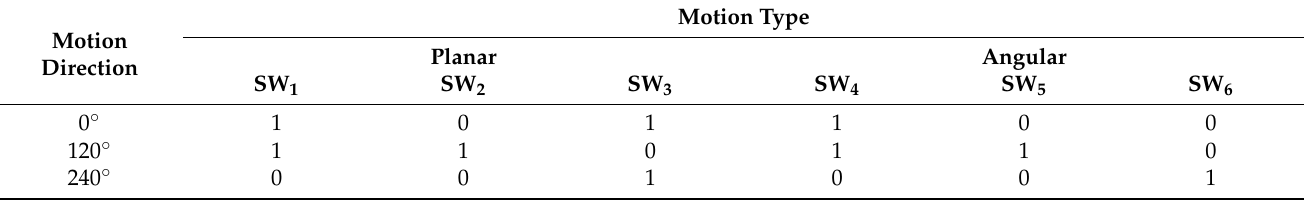
Figure 3. Excitation schematics of the robot; 1—excitation signal source; 2—switching box dedicated to controlling planar motion; 3—switching box dedicated to controlling angular motion. Table 2. Control signals of the